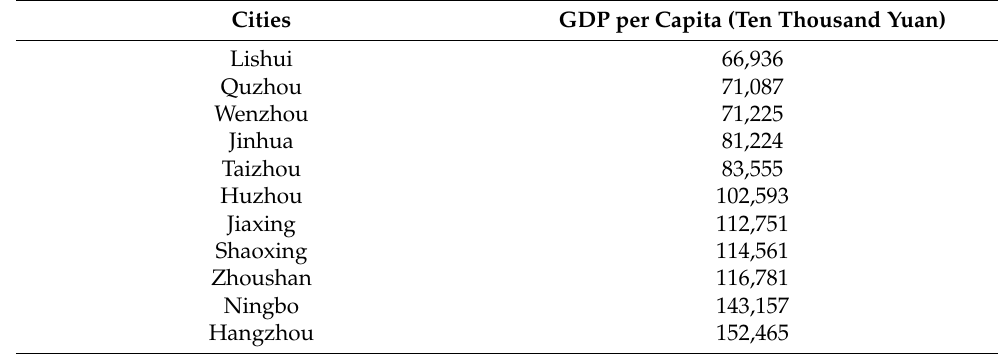
Table A2. Basis for the first stage of sampling: per capita GDP of 11 cities in Zhejiang province in 2019.